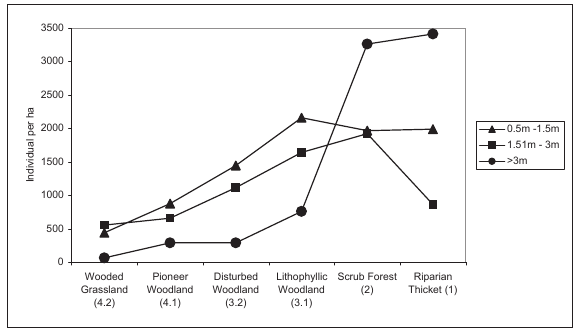
Figure 5 Number of trees per hectare in each height class for six woody-species assemblages of Zululand coastal